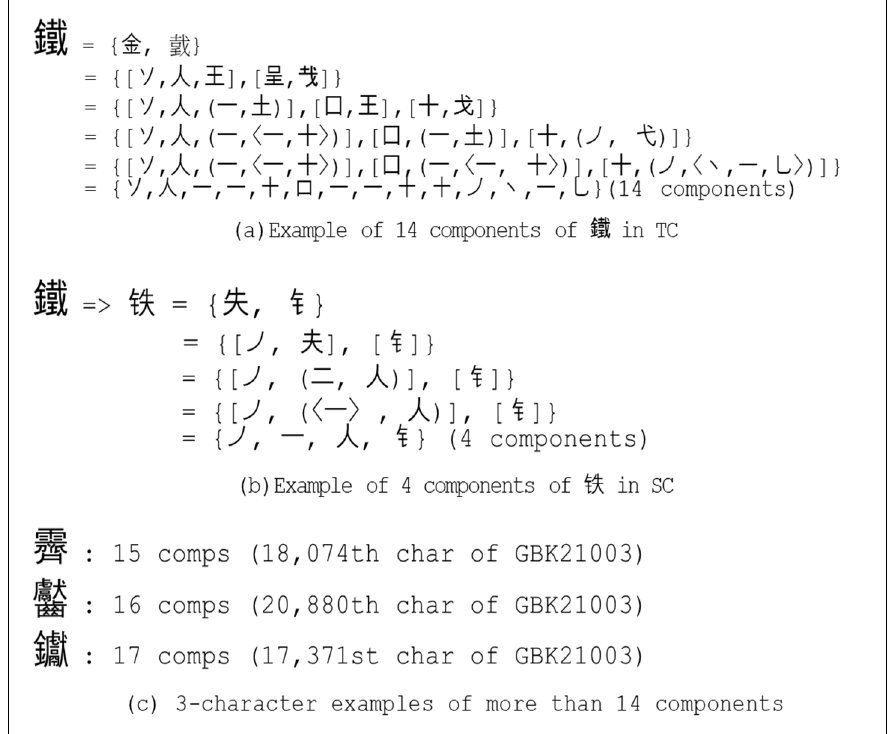
Figure 10. ( a ) Decomposition examples of 14 components of 鐵 in TC; ( b ) four components of 铁 in SC; and ( c ) three-character examples of more than 14 components in GBK21003.